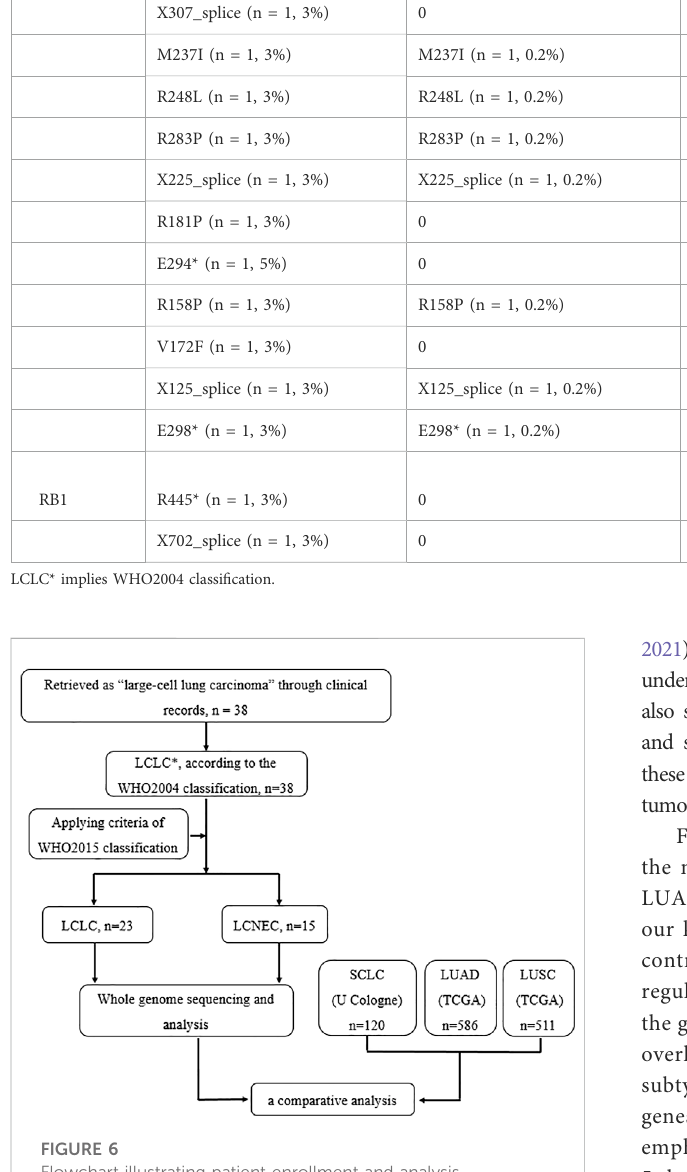
FIGURE 6 Flowchart illustrating patient enrollment and